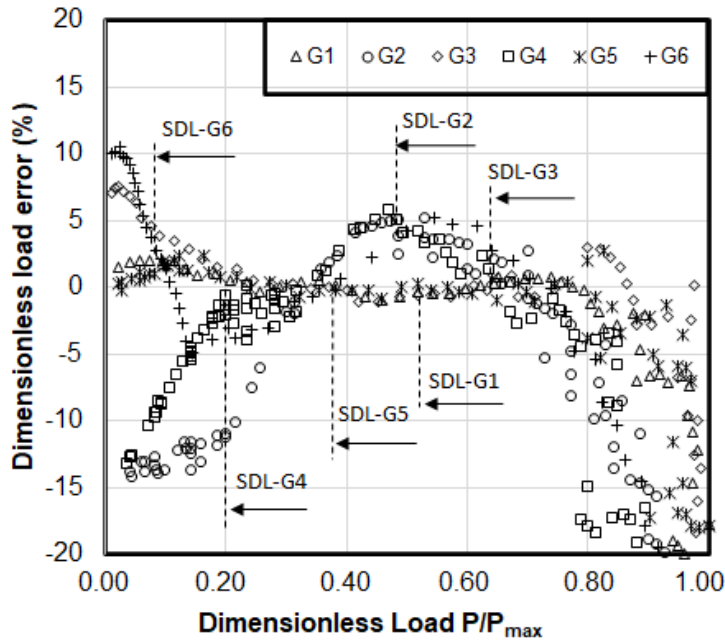
Figure 7. Estimation error of the dimensionless load, P/P max .